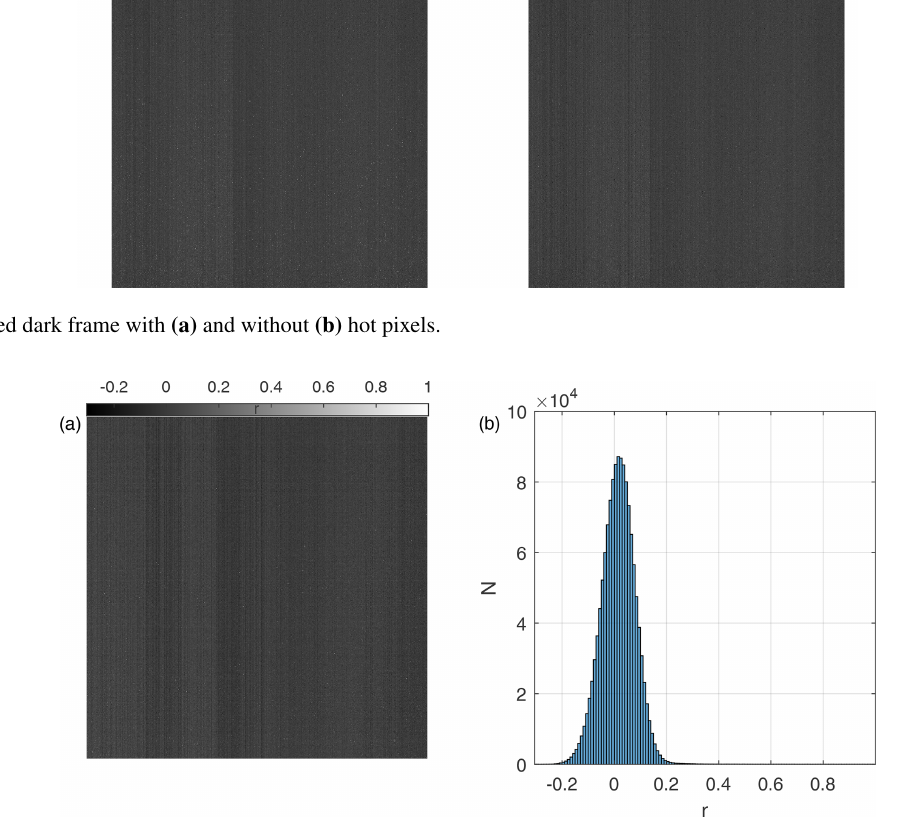
is more feasible than using a controllable and variable light